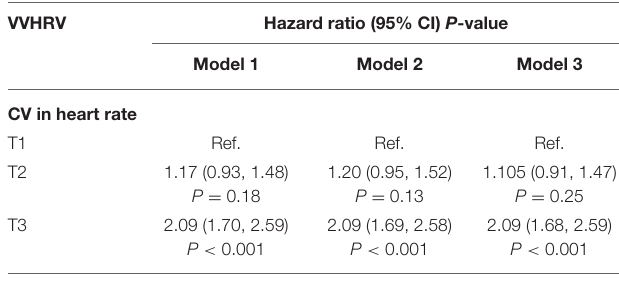
TABLE 2 | Association between visit-to-visit heart rate variability and composite cardiovascular outcomes in different